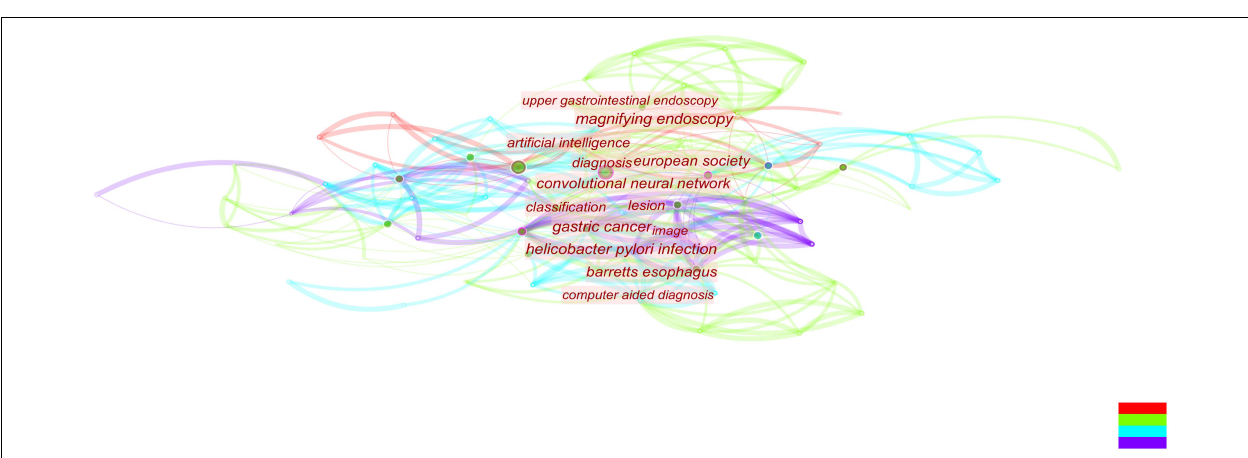
FIGURE 9 | Combined with literature on early gastric cancer, artificial intelligence, and endoscopy, convolutional neural networks occupy the center and become an absolute research